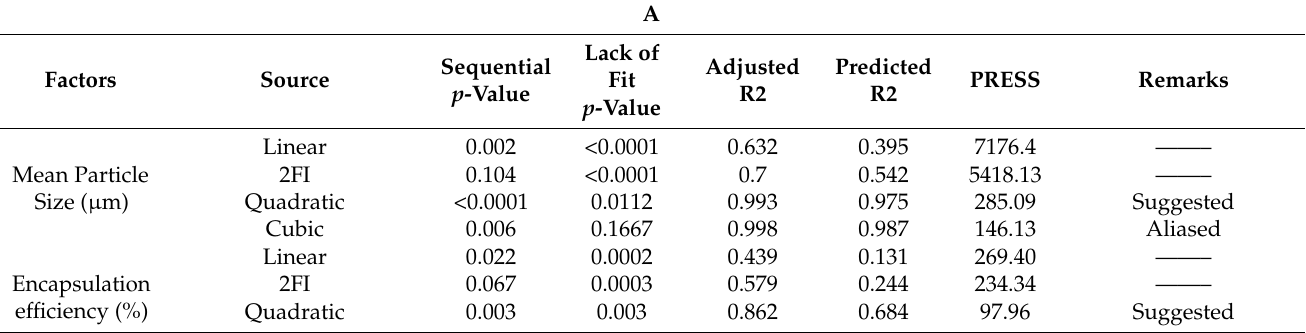
Table 3. A . Fit Summary for regression model selection. B . ANOVA results for regression model equations.